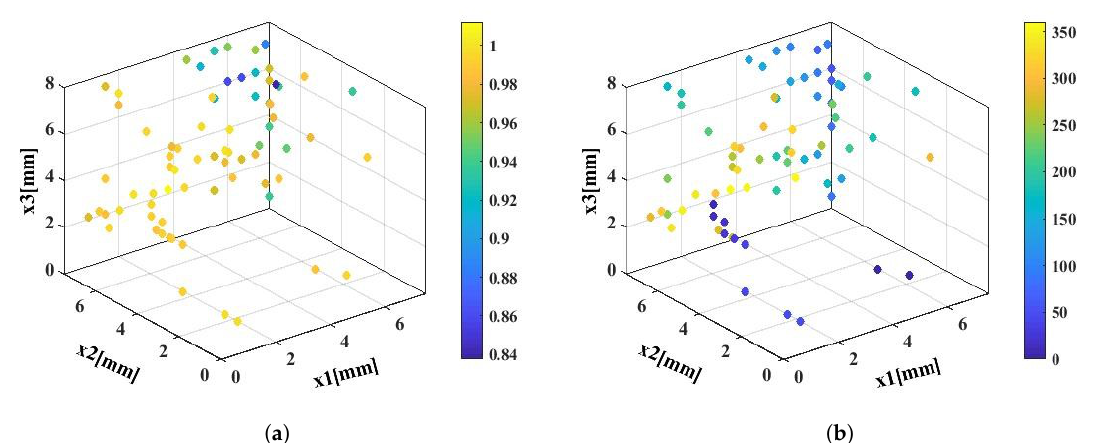
Figure 3. Variation in ( a ) transmission magnitude plots: ( b ) transmission phase (degrees) plots against the relative cube sizes for x1, x2 and x3 for five-layer cube